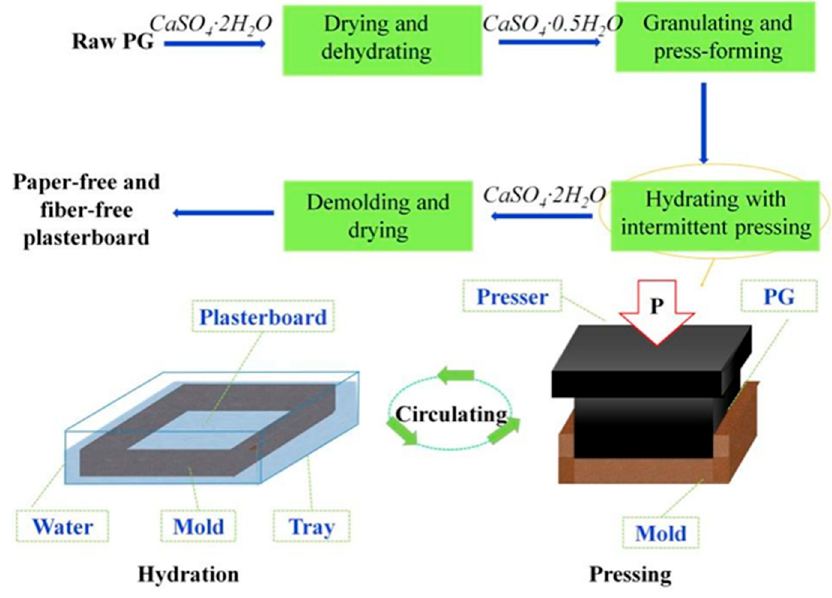
Figure 6. Flowchart of the intermittent pressing hydration process for preparing paper and fiber-free plasterboards [73].